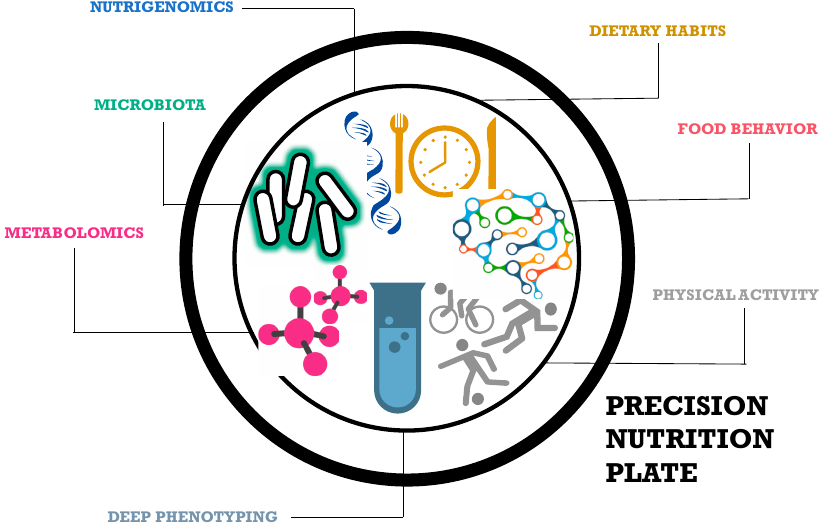
Figure 1. The precision nutrition plate . A schematic representation of the main factors worth to consider when approaching precision nutrition.